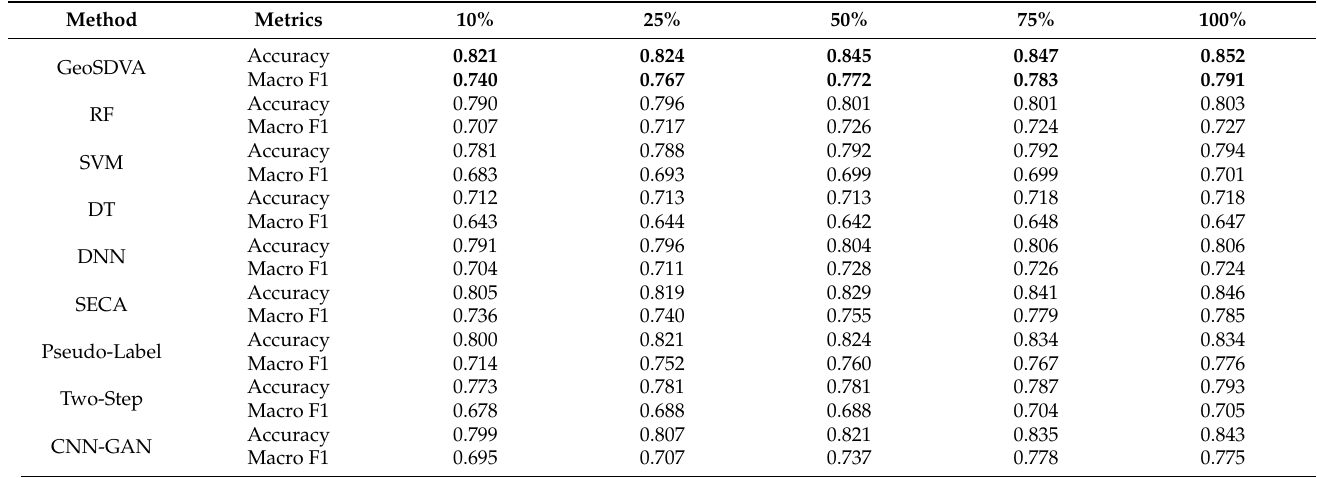
Table 6. The performance of different models on the MTL Trajet 2017 dataset.